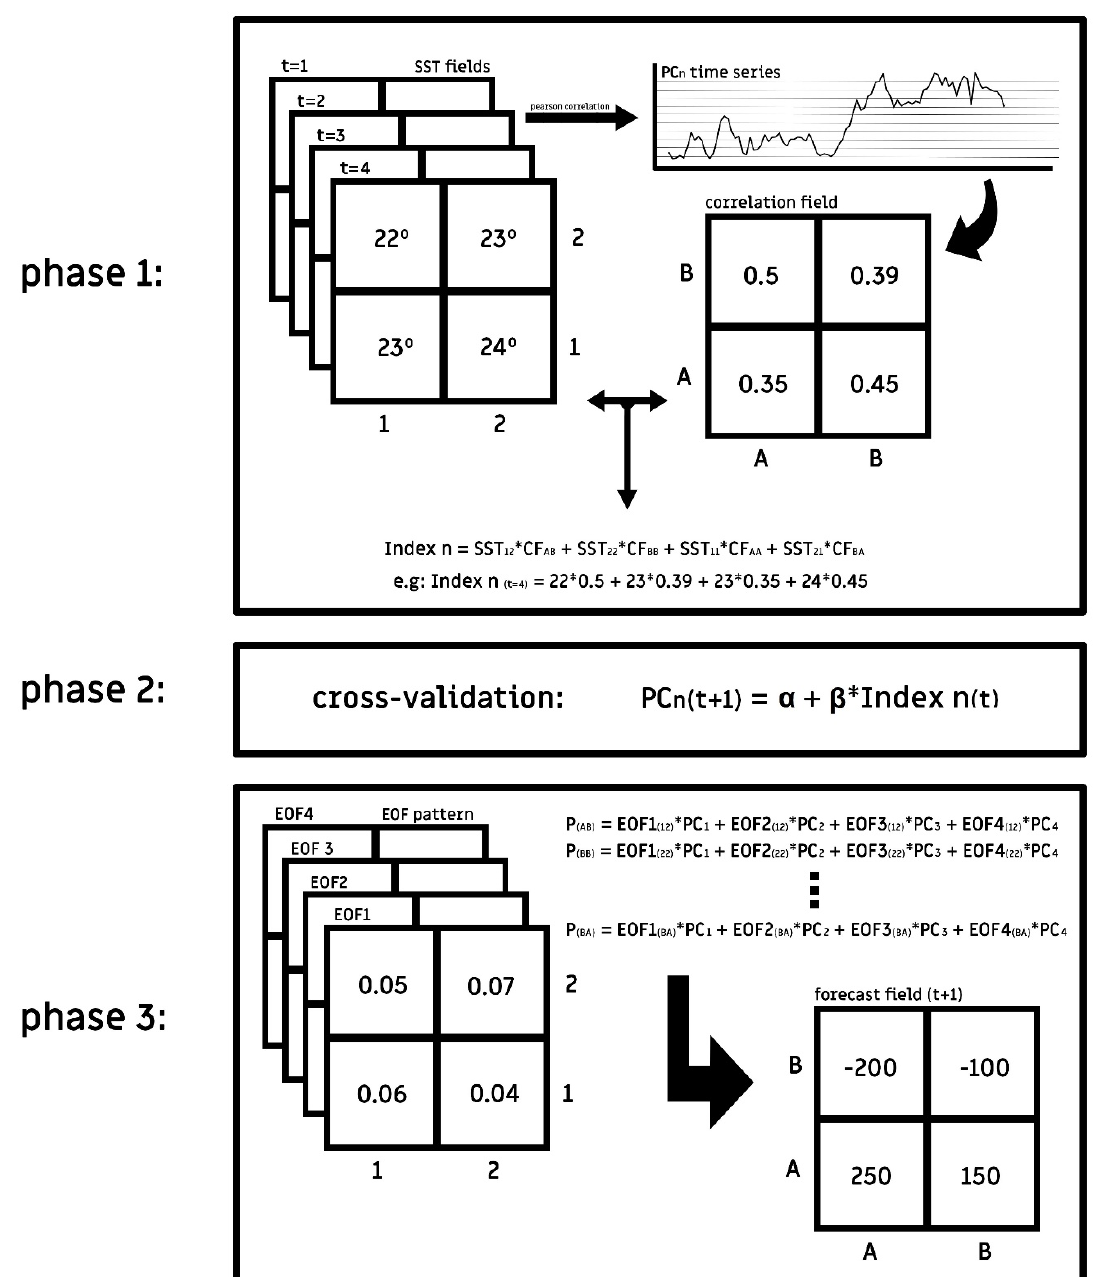
Figure 2. Explanatory diagram of the adjustment, validation and forecast phases of the model.